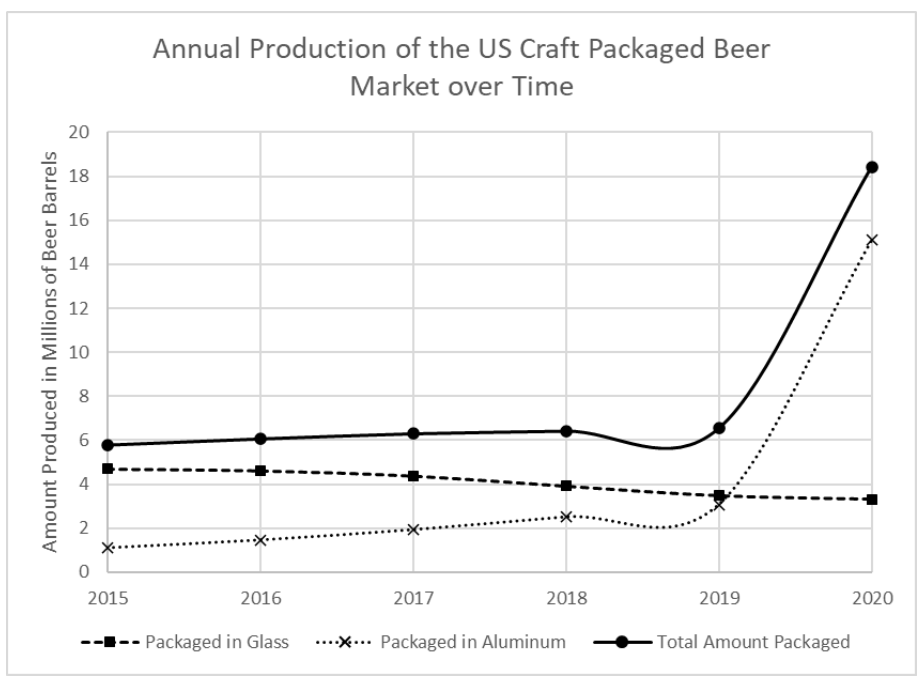
Figure 2. The sudden upswing in packaged product production in 2020 was because of the need for off-premise sales and the limited market for on-premise sales due to the pandemic. Data provided by the Brewers Association, a trade organization that represents the craft brewing industry [31,32].